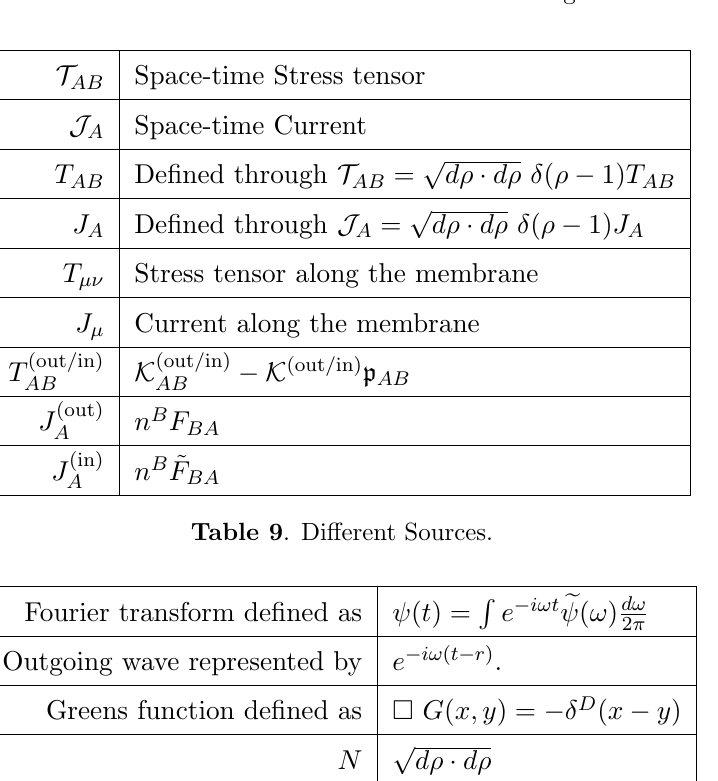
Table 8 . Intrinsic curvature and Field strength.